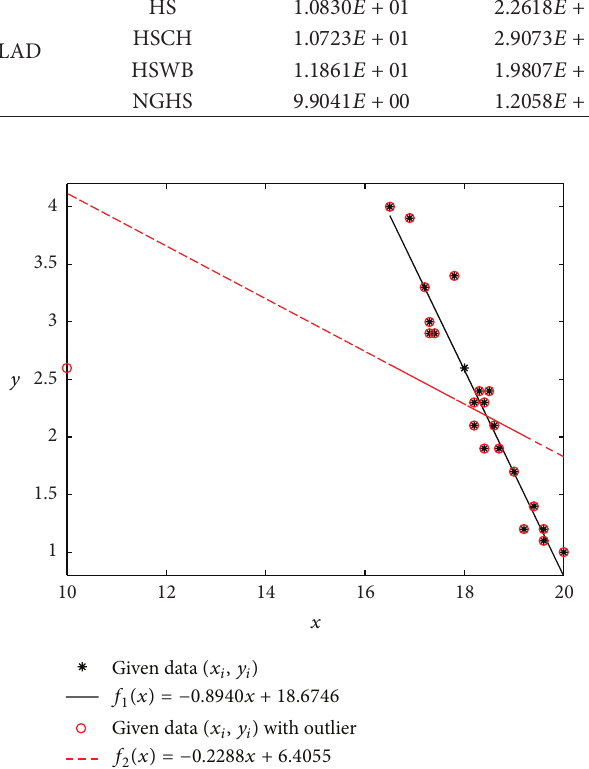
Figure 1: Data fitting results by LSR method. Here 𝑓 1 (𝑥) = −0.8940𝑥 + 18.6746 is fitting results of data in Table 1, and 𝑓